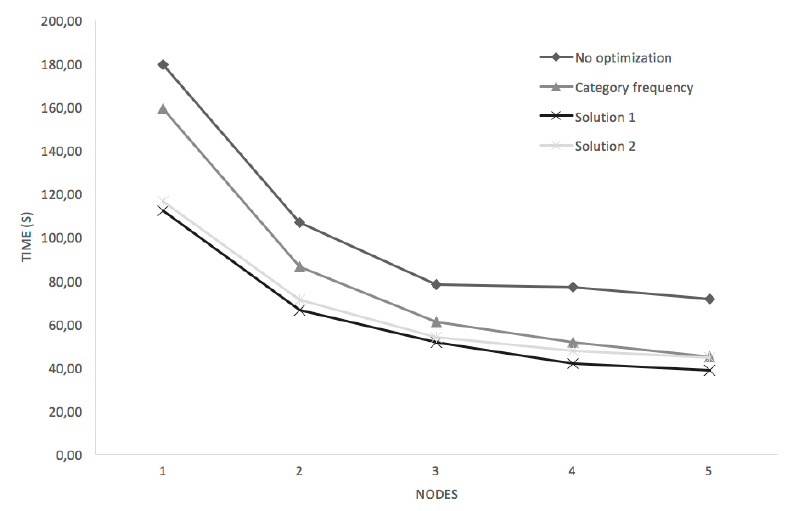
Figure 5. Reuters dataset, homogeneous environment.